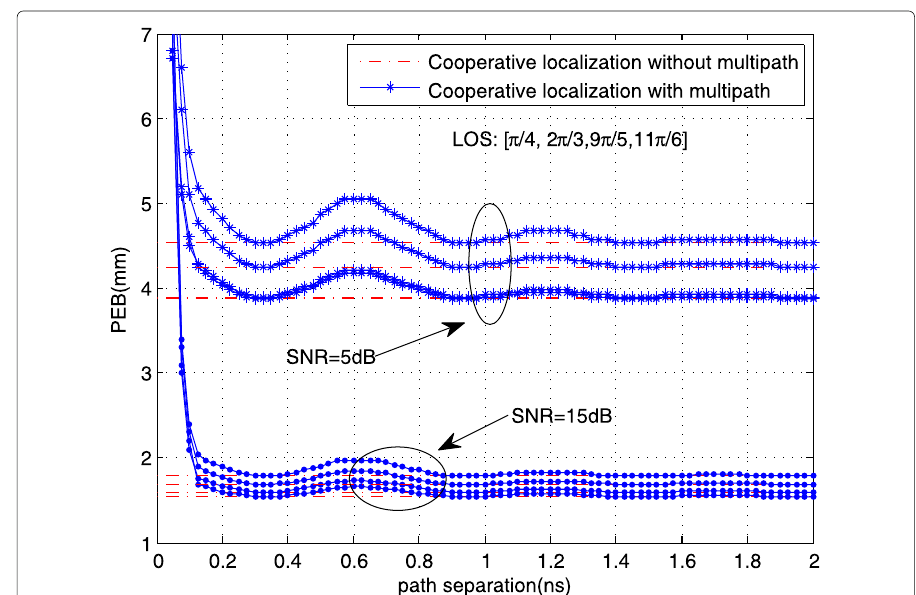
Fig. 12 PEB of single anchor-based cooperative localization, as a function of path separation, where different SNRs are considered